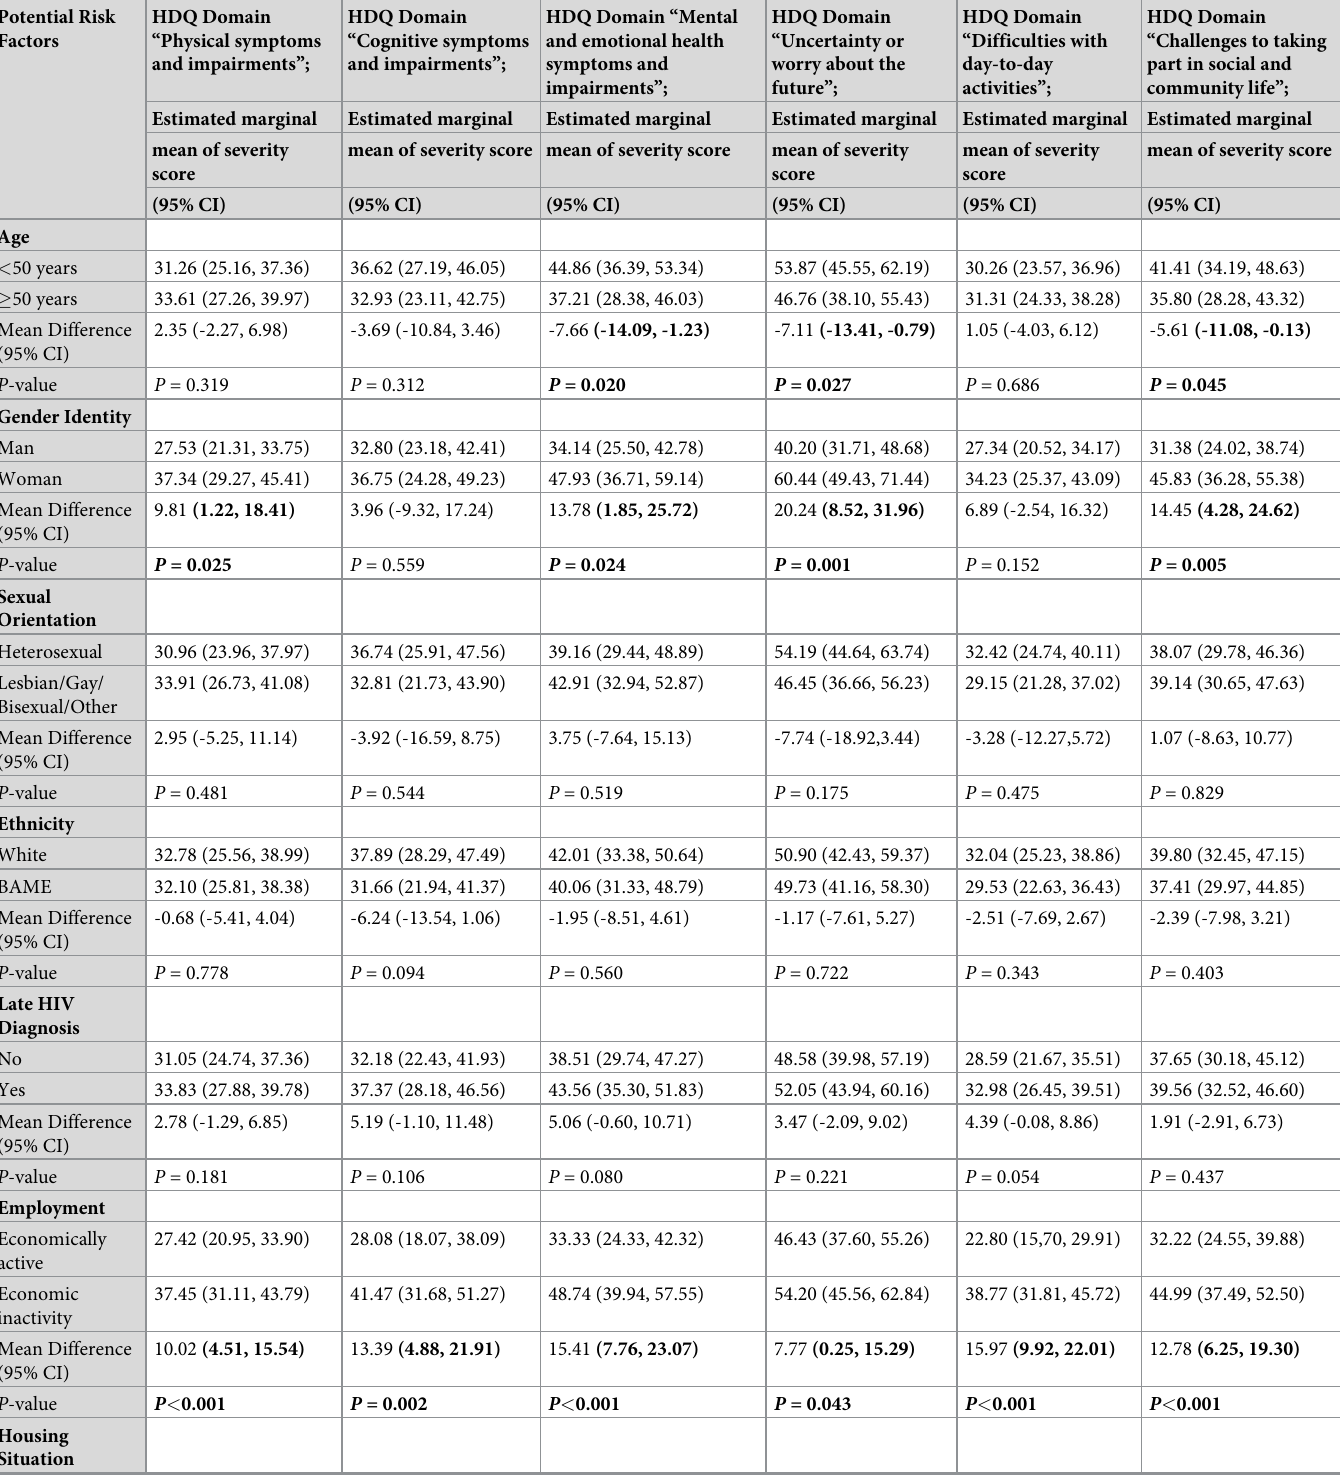
Table 4. Potential risk factors as predictors of HDQ domain severity